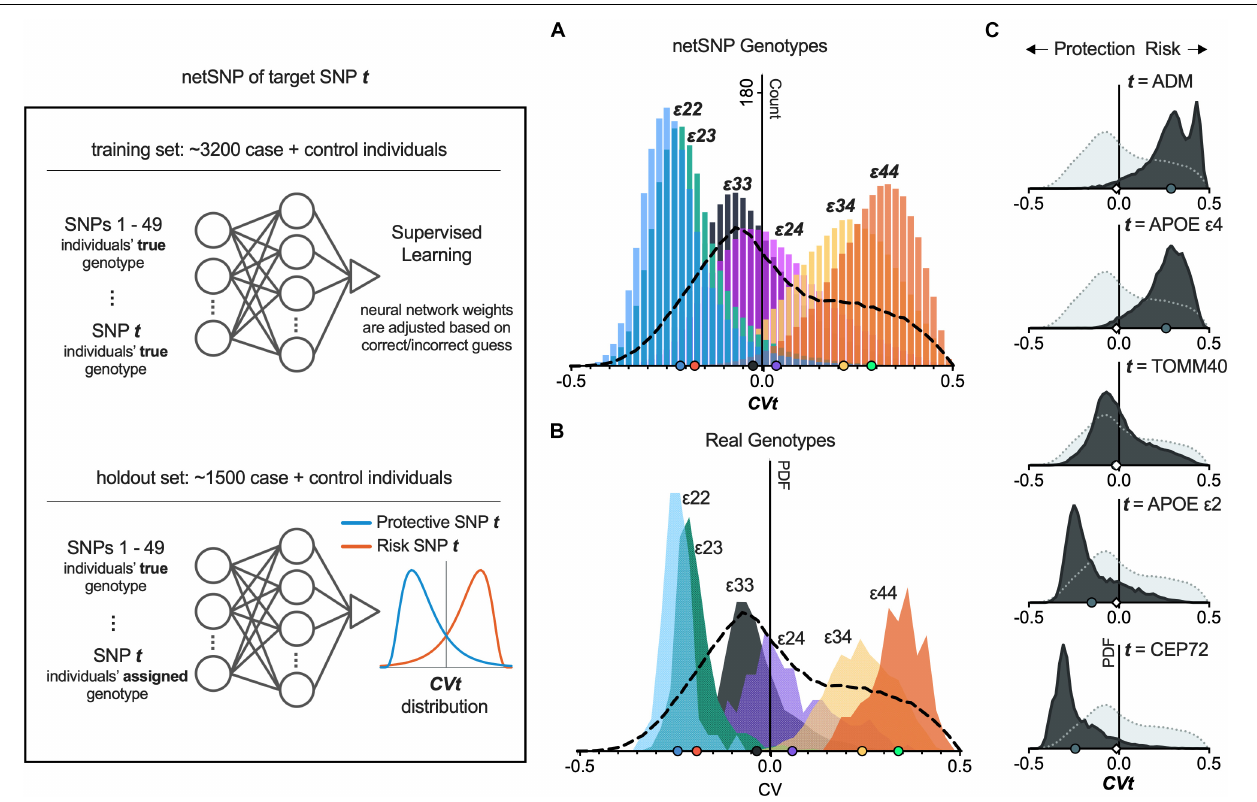
FIGURE 3 | netSNP accurately reproduces CV values for APOE genotypes and identifies potential AD-risk and AD-protective SNPs. (Left) Diagram of netSNP method; details in text. SNP t assignment, APOE genotype for A; and homozygous MFA for C. (A) netSNP-generated CVt values for all holdout set individuals (all APOE genotypes) with their genotype artificially assigned to indicated genotype. The dashed line indicates distribution of CV values for all holdout set individuals with correct genotype. (B) Frequency distribution of CV values for holdout set subsets containing only individuals with indicated APOE genotype. Dashed line as above. (C) Example netSNP-generated CV distributions for all holdout individuals with true genotype (light gray) or CVt with indicated target SNPs (dark gray) assigned alt/alt; symbols on X -axis: mean CVt (mCVt) values. Note that mCVt value for TOMM40 SNP is close to zero, indicating that it perturbs NN output little (i.e., provides little additional information) when APOE SNPs are used in training. CVt distributions for 50 tSNPs shifting CV most to the left and 50 tSNPs shifting CV most to the right are shown in Supplementary Figure 5 . tSNPs having potentially a protective effect on individuals with APOE4 are shown in Supplementary Figure 5 , Supplementary Table 2 , and